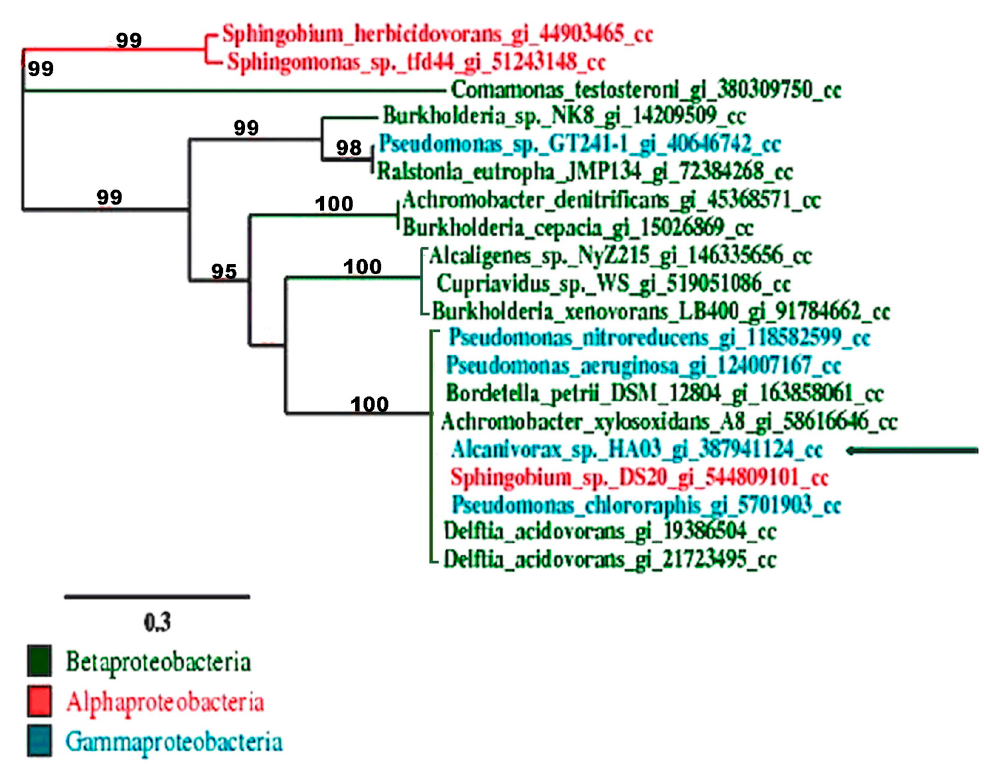
Figure 5. Phylogenetic tree for the chlorocatechol 1,2 dioxygenase from Alcanivorax sp. HA03 (indicated with an arrow) and its similarities with the other chlorocatechol dioxygenase from the other strains.